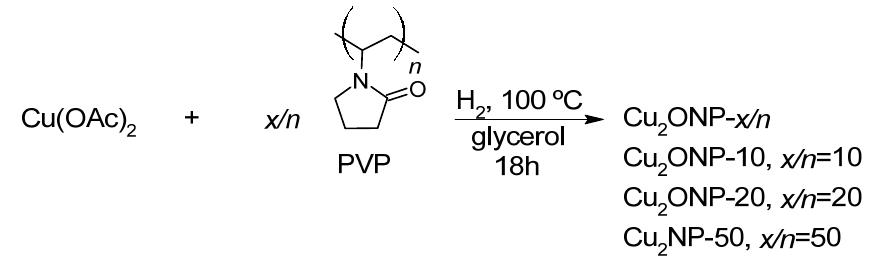
Figure 4. Synthesis of copper(I) oxide nanoparticles, Cu 2 O NPs, in glycerol. Reproduced with permission from [16], published by John Wiley and Sons, 2014.